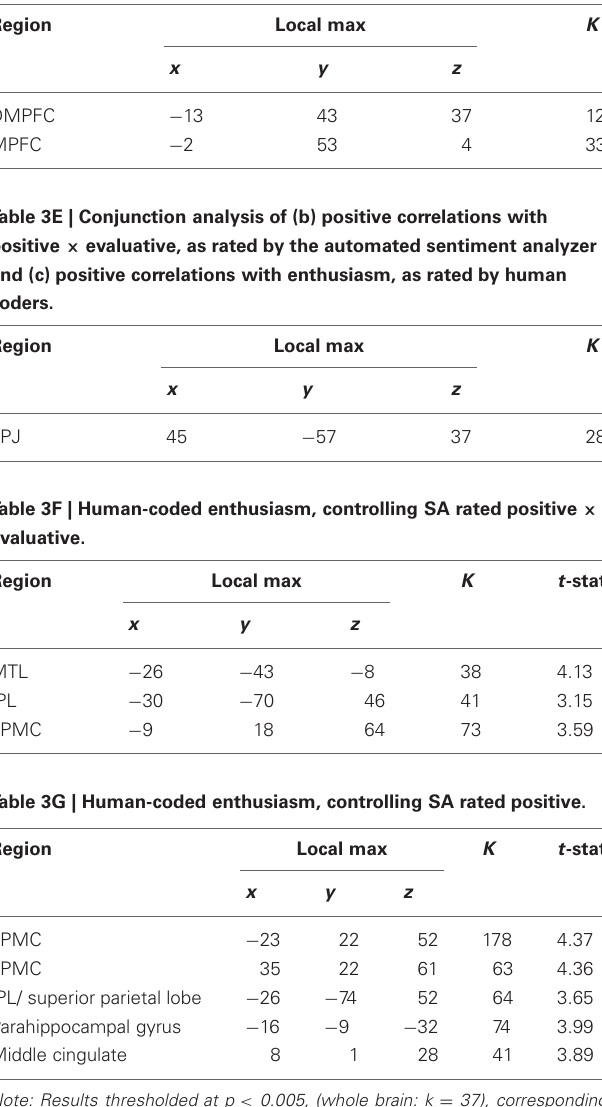
Table 3D | Conjunction analysis of (a) positive correlations with positive sentiment, as rated by the automated sentiment analyzer and (c) positive correlations with enthusiasm, as rated by human coders.